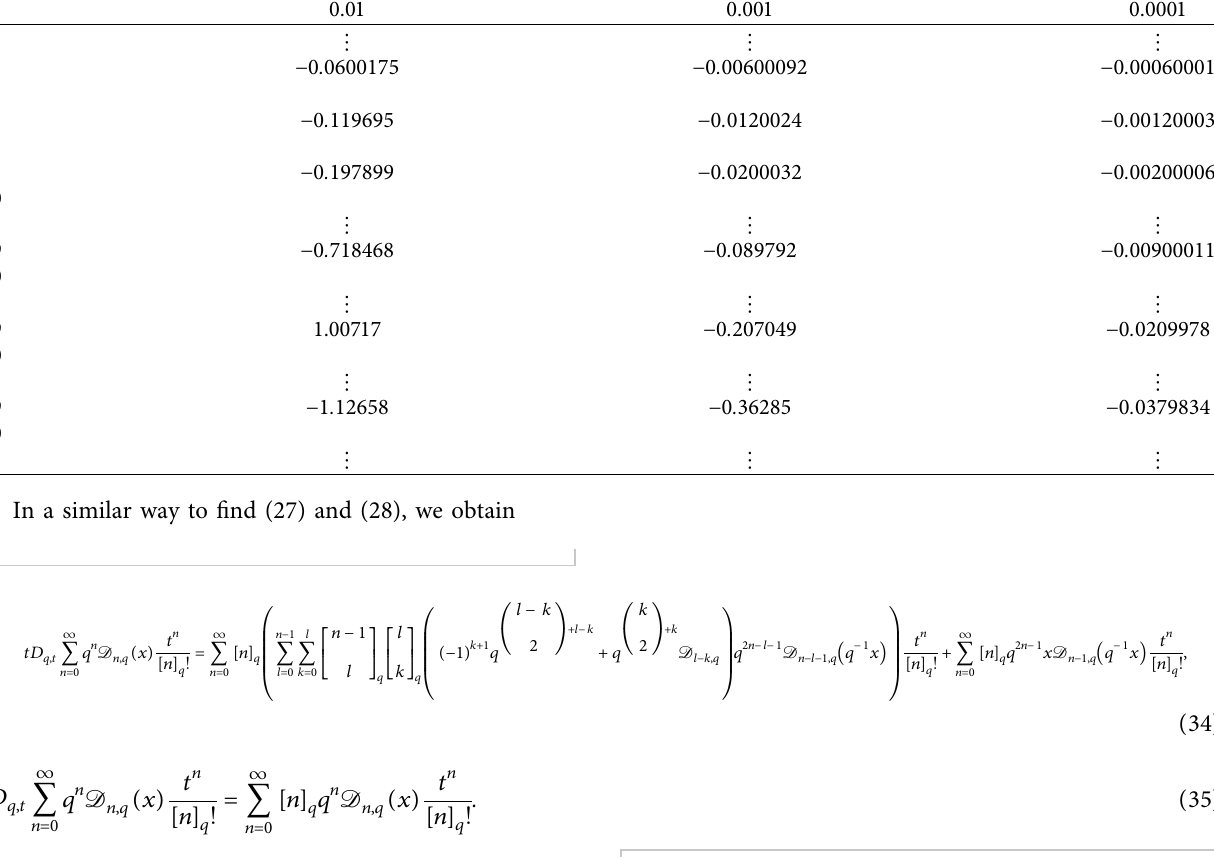
Table 4: Approximation real roots of D